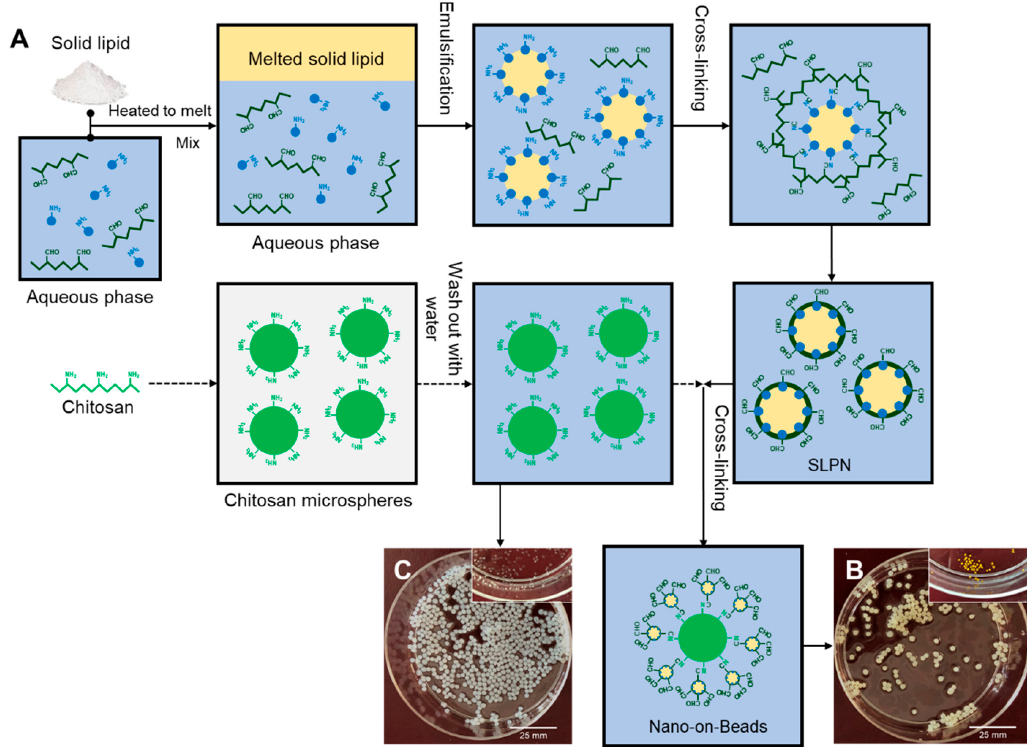
Figure 1. ( A ) The formulation of solid lipid–polymer hybrid nanoparticles (SLPN) and the fabrication of nano-on-beads composite with as-prepared SLPN; ( B ) hydrated and dehydrated (top-right) states of SLPN functionalized chitosan beads; ( C ) hydrated and dehydrated (top-right) states of pure chitosan